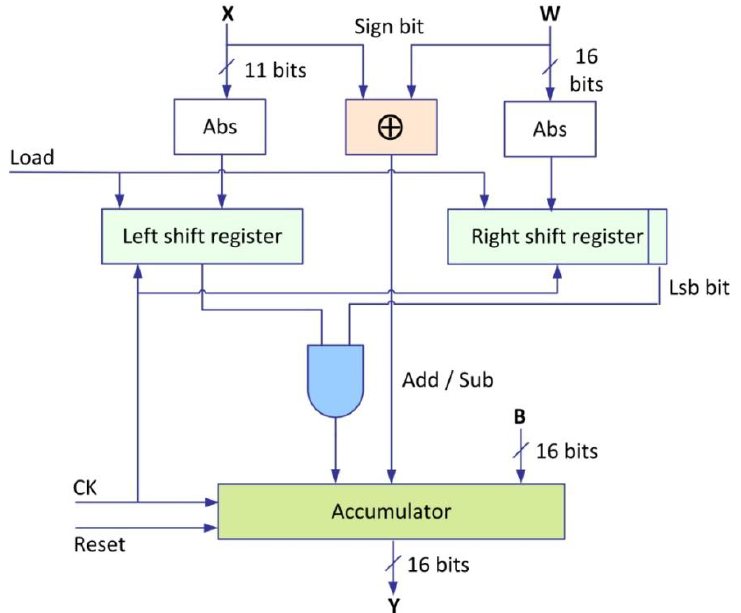
Figure 10. The designed MAC